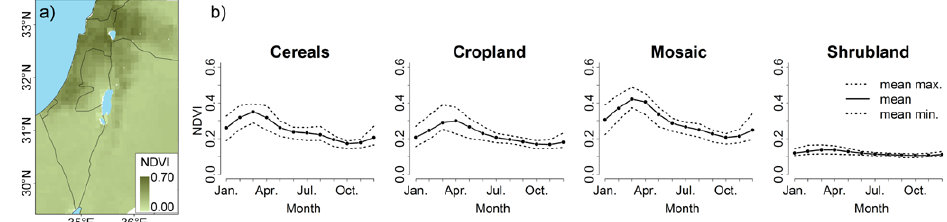
Fig. 2. (a) Spatial distribution of NDVI in April 2000, and (b) the NDVI phenology throughout the year for chosen land uses. Shown are the maximum mean NDVI, the mean NDVI, and the minimum mean NDVI based on monthly values for the years 1982–2001.